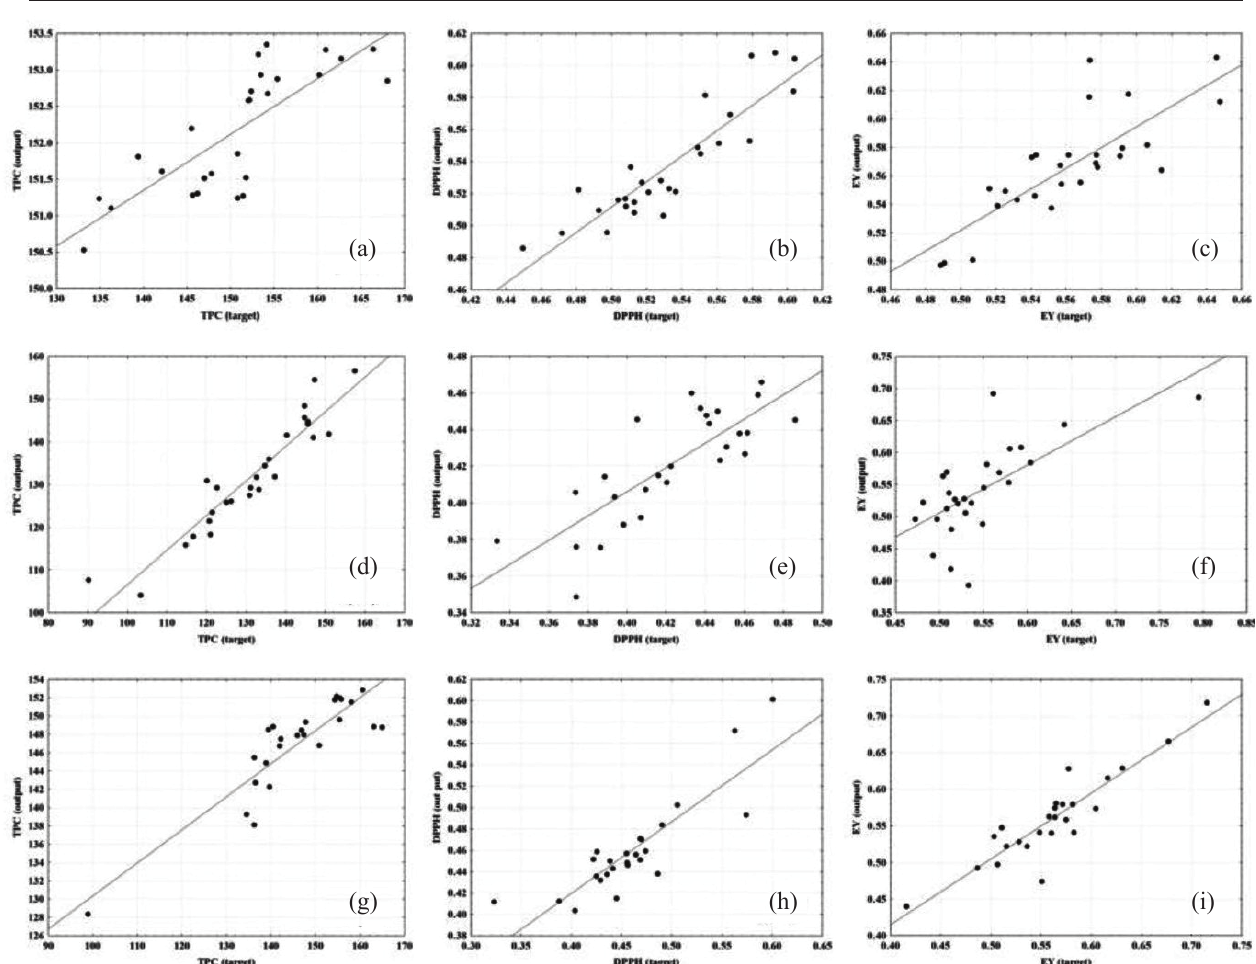
Fig. 3 – Comparison between experimental data and ANN models predicted data for classical extraction procedure for (a) total polyphenolic content – TPC, (b) antioxidant activity – AA, and (c) extraction yield – EY; for microwave-assisted extraction procedure for (d) total polyphenolic content – TPC, (e) antioxidant activity – AA, and (f) extraction yield – EY; microwave-ultrasound-extraction procedure for (g) total polyphenolic content – TPC, (h) antioxidant activity – AA, and (i) extraction yield –